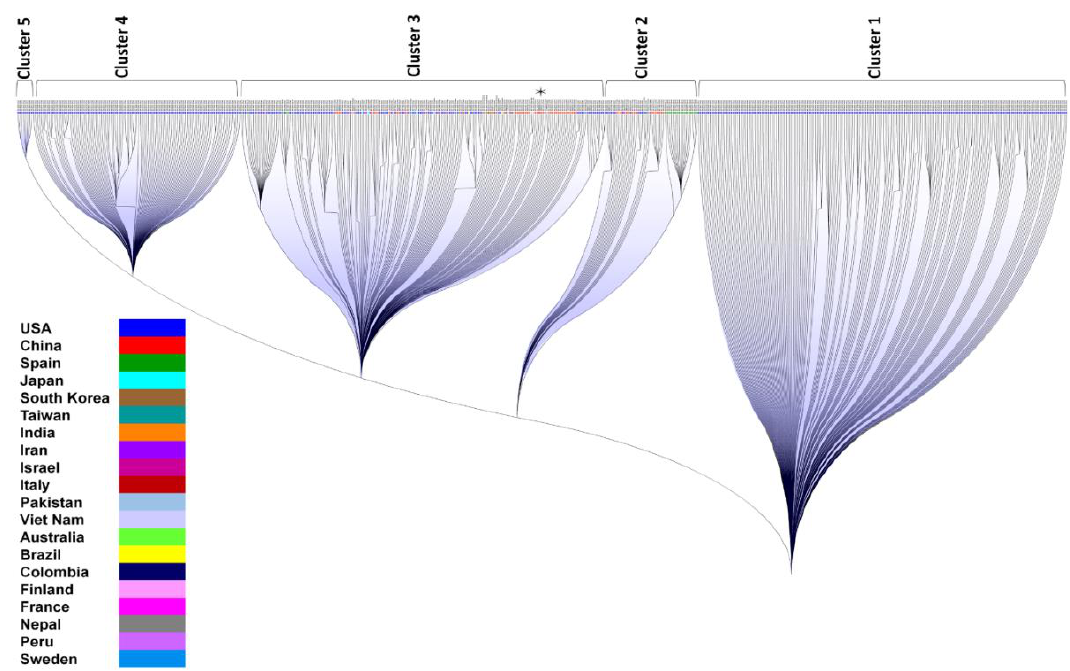
Figure 6. Bootstrap phylogram showing the clusters of SARS-CoV-2 isolates among 20 different countries / territories. A total of 540 genomes of SARS-CoV-2 formed as five distinct clusters. The reference genome from the China outbreak was observed to form in cluster 3 represented with a star. The internal branching depicts the genomic divergence within each cluster.